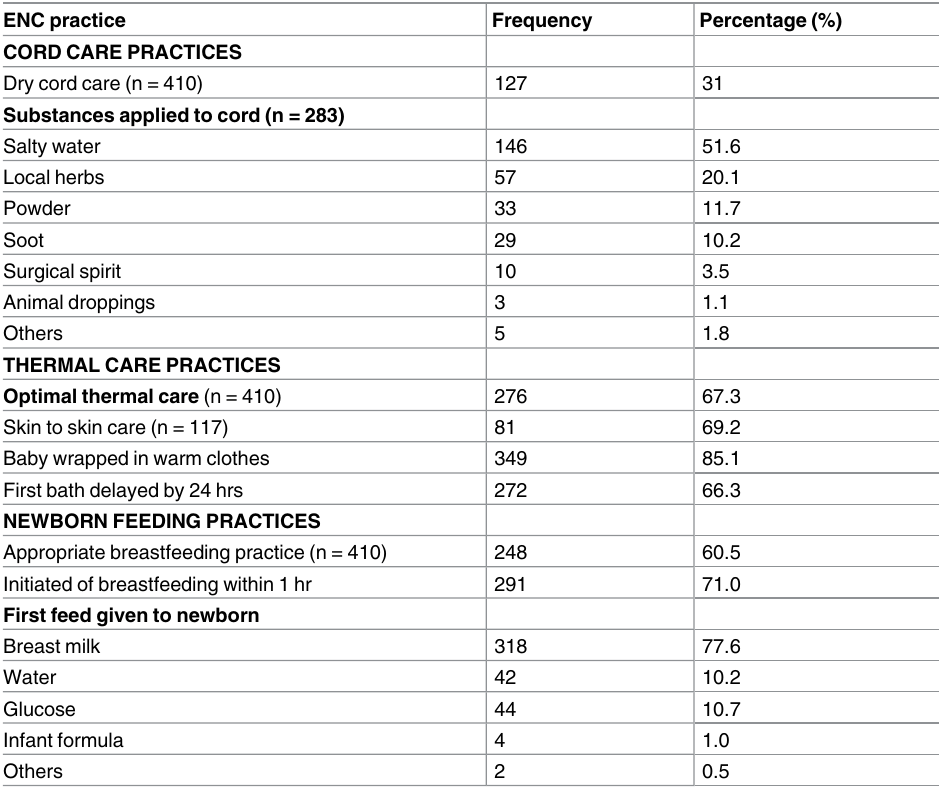
Table 2. Essential Newborn Care practicesby the adolescent